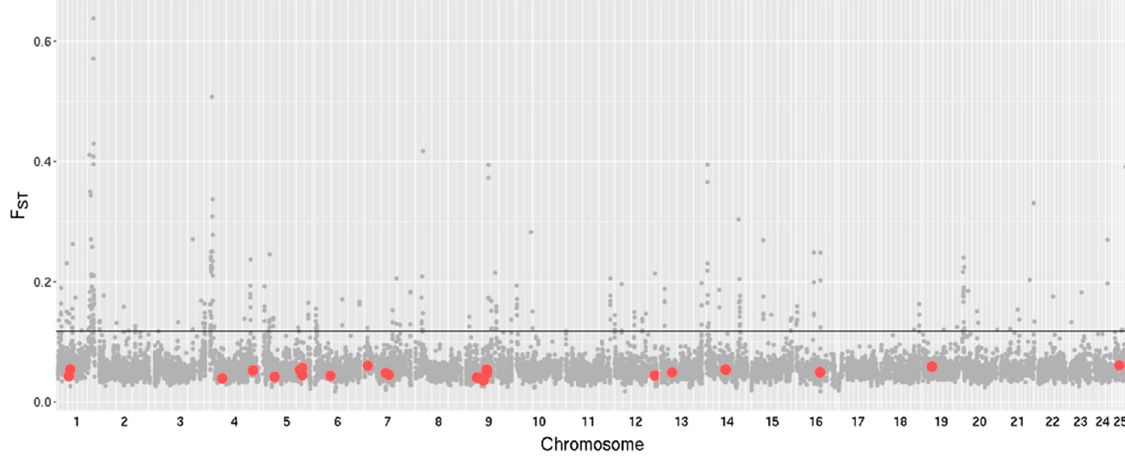
Figure 7. The genome-wide F ST (fixation index) values of 5 kb flanking regions, estimated per gene ( n = 13,692). Phagocytosis genes ( n = 73) are indicated (red dots), with many in close proximity. The grey line shows the 97.5th percentile of the analysis, peaks above this line denote highly differentiated SNPs.